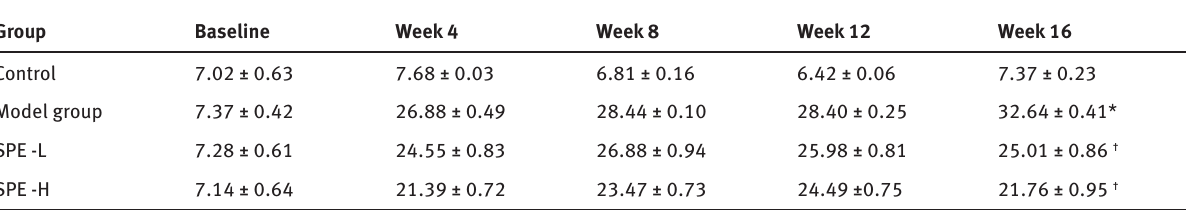
Table 2: Comparison of 24 h urine protein in each group